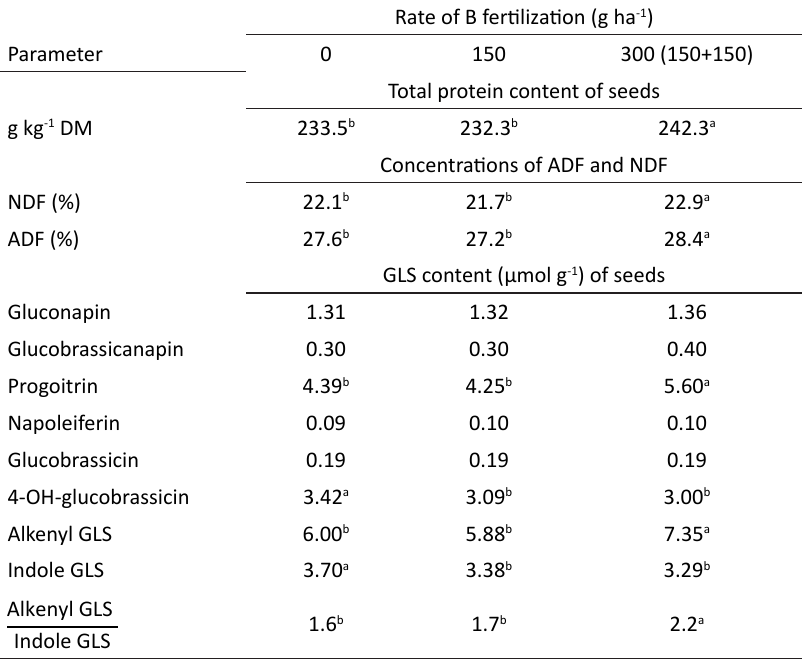
Table 8. Influence of foliar application of B on the feed value of the seeds of winter oilseed rape (across years)